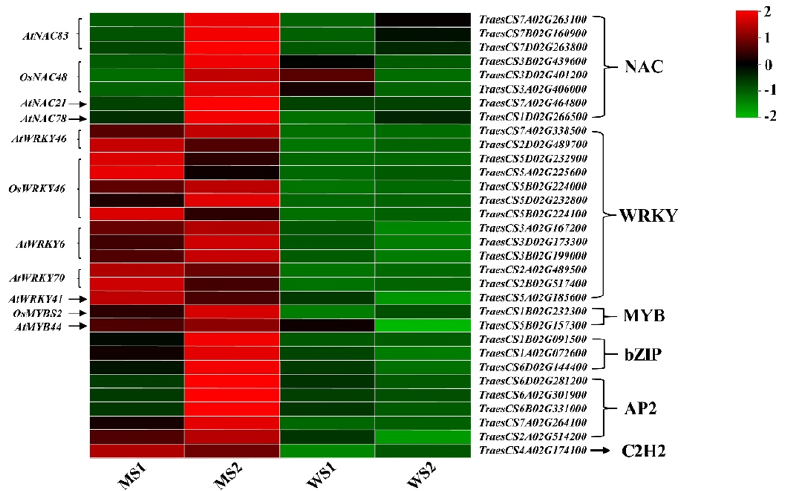
Figure 10. expression profile clustering of transcription factor related genes. The expression ratio is standardized based on normalized transcripts per kilobase million (TPM) values, where each vertical column represents the mean of three samples (MS1, MS2, WS1 and WS2), and each horizontal row represents a sample single gene.